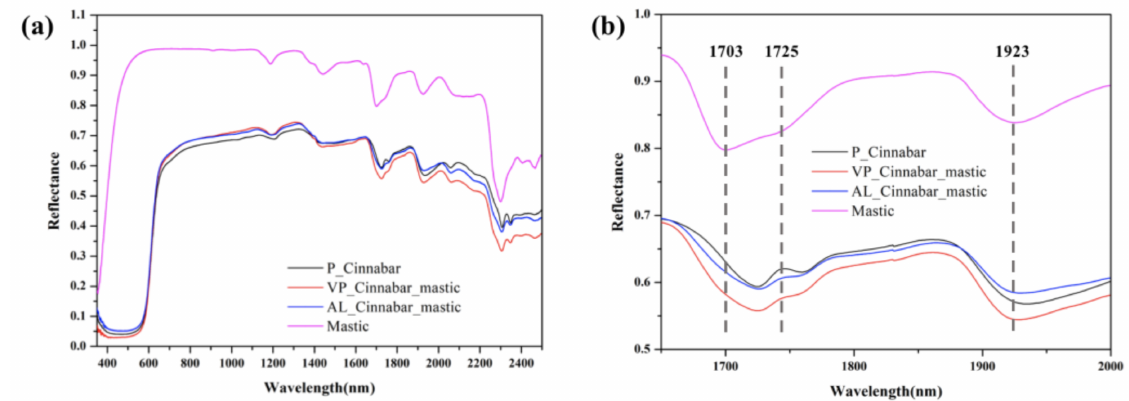
Figure 7. The full range reflectance spectrum ( a ) and the selected region reflectance spectrum ( b ) of pure mastic, cinnabar tempera mock-up (P), cinnabar tempera varnished with mastic (VP) and mock-up after laser cleaning (AL). All spectra reported were collected in Section 8 of painting mock-ups (Figure